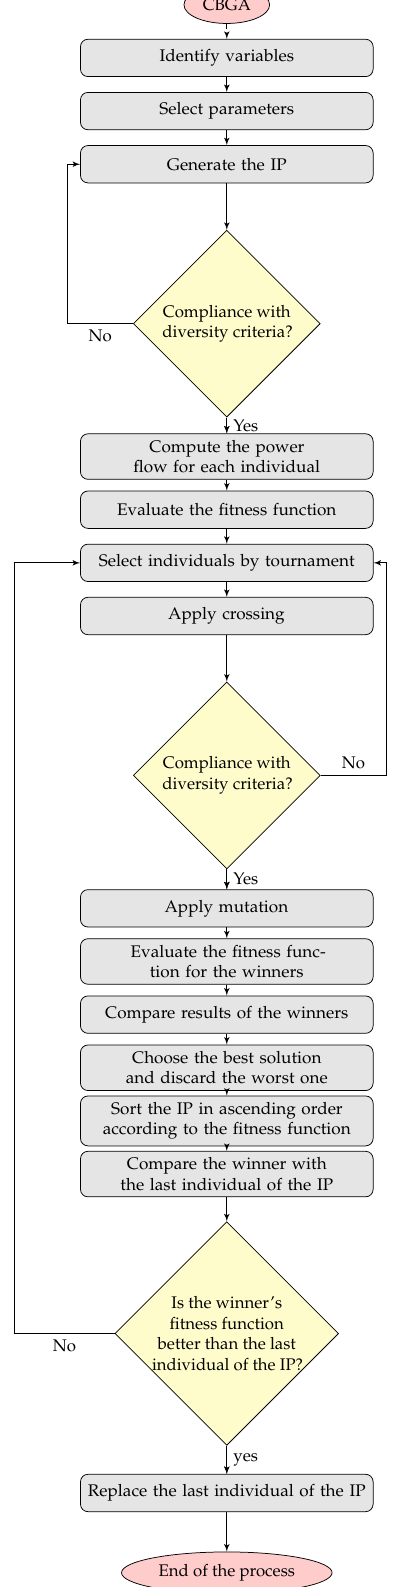
Figure 2. Flow diagram of the proposed CBGA for the optimal location of fixed-step capacitors in distribution